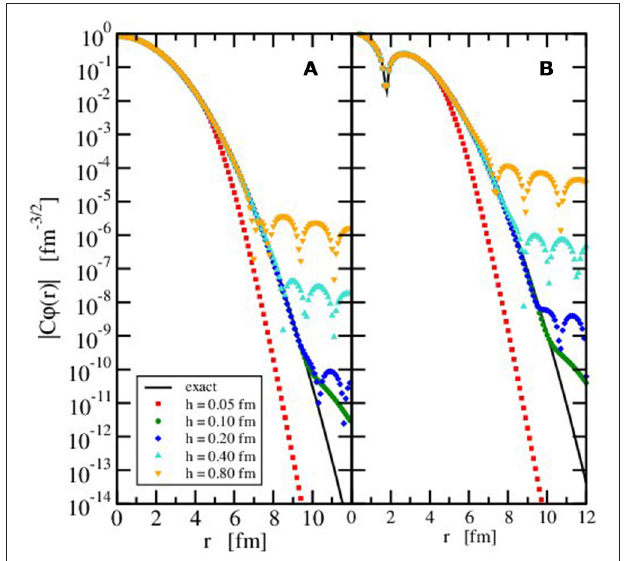
FIGURE 3 | Modulus of the scaled radial wave function of the ground (A) and first excited (B) state with orbital angular momentum l symmetric relativistic harmonic oscillator with m 938 MeV/ c 2 in the exact case (full black line) and the calculation with the = Lagrange-mesh method for different number of grid points N (colored symbols) and constant scale parameter ( h C is explained in the text.